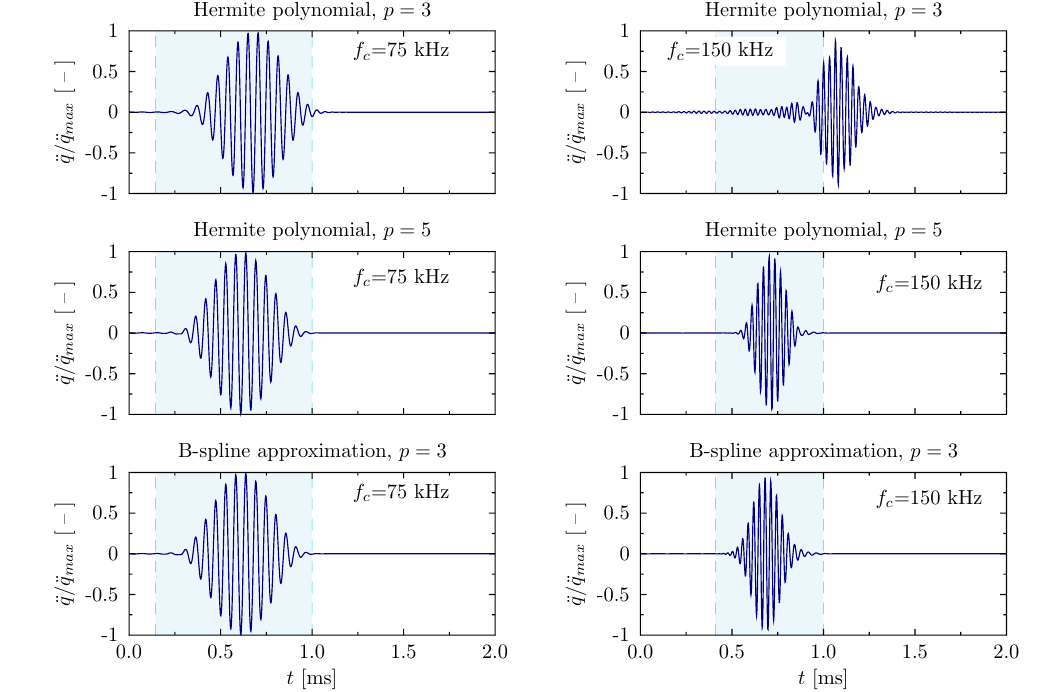
Figure 13. Wave propagation patterns of the beam calculated based on different approximation polynomials for the carrier frequencies f c = 75 kHz and f c = 150 kHz, in the case of a beam with free